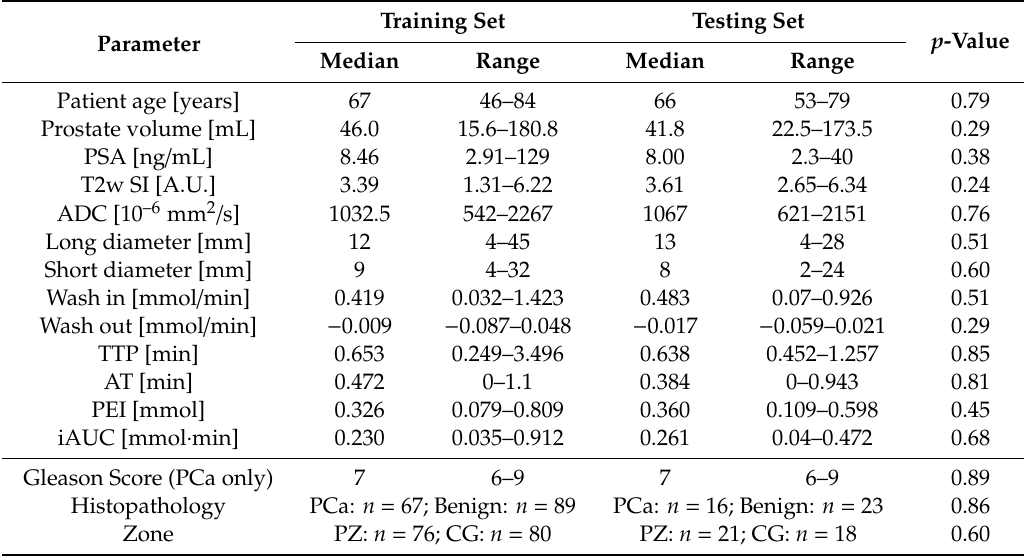
Table 1. Comparison of the acquired parameters and additional lesion characteristics between the lesions from the training set ( n = 156), and the testing set ( n = 39).